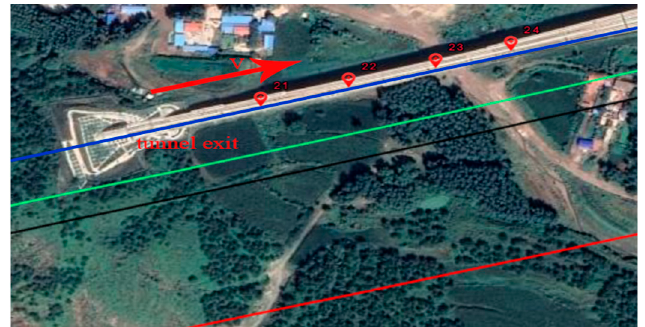
Figure 9. Trajectory located at the exit of 9063 m tunnel. Table 2. Horizontal position errors of different algorithms at the reference points near the 9063 m tunnel exit. P-INS TMC-INS CIAMC-INS MIMU/ODO/MC Point Distance(m)